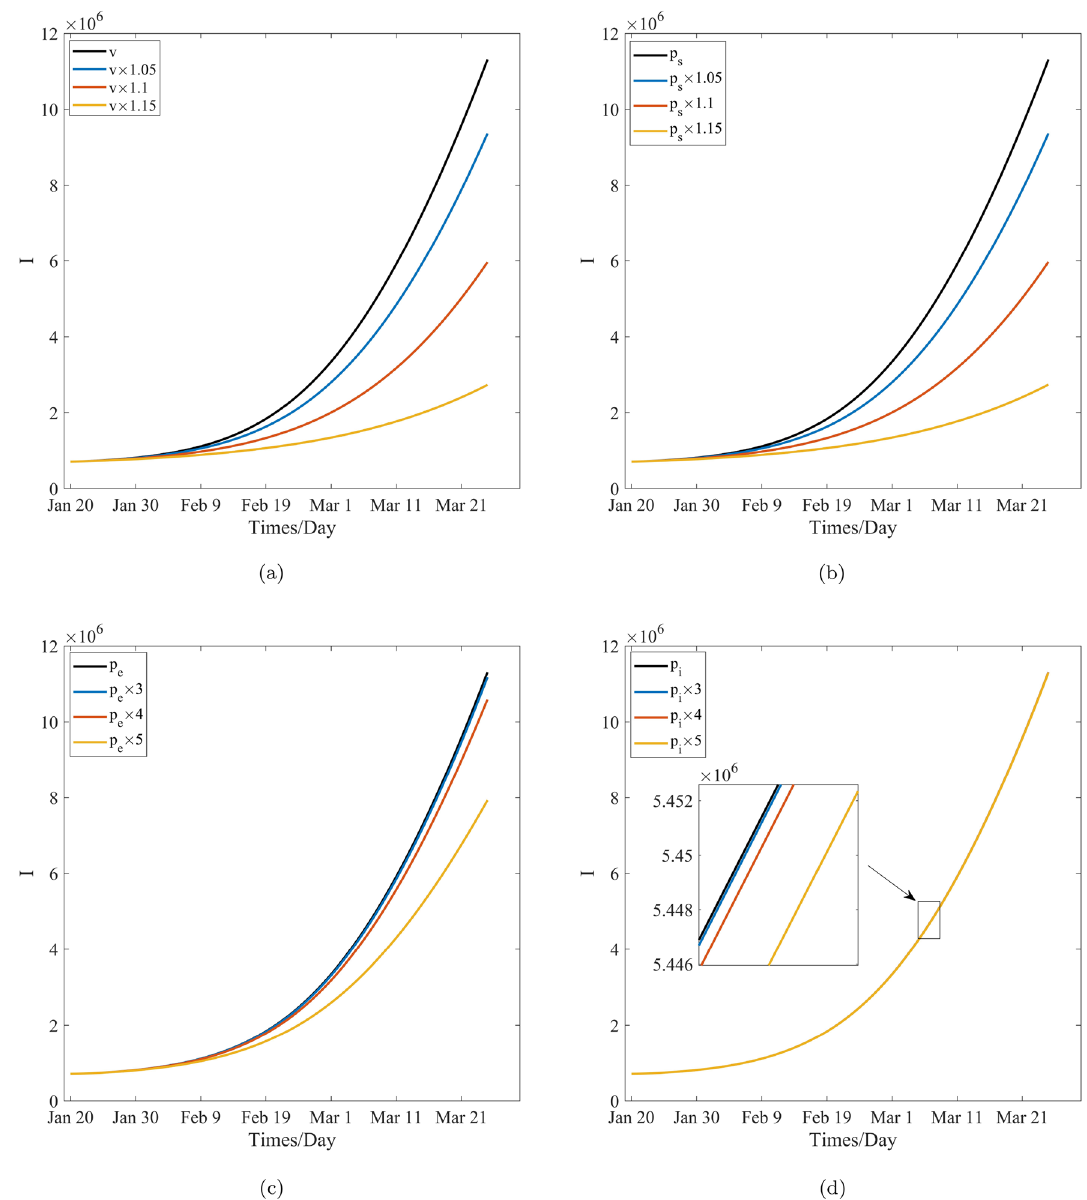
Figure 9. The effect of the critical parameters v , p s , p e and p i on the cumulative